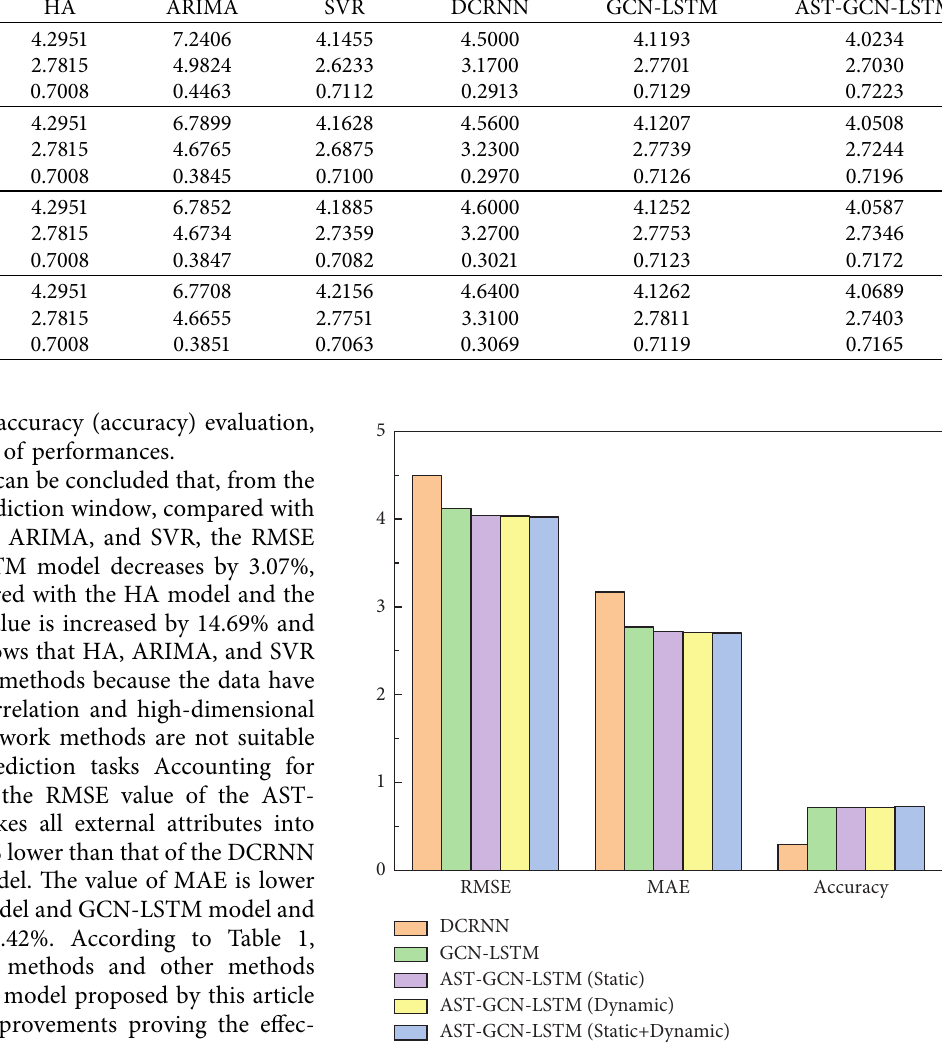
Figure 5: Experiments under different